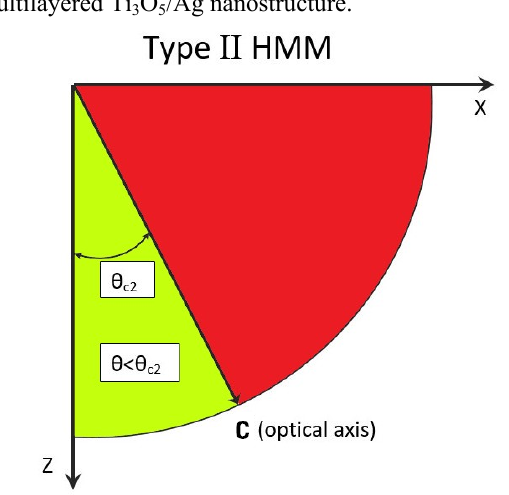
Figure 7: The spectral dependences of the angles =arcsin (Y ) 1/2 for the II type HMM on the basis of Θ 3,4 3,4 multilayered Ti O /Ag nanostructure. 3 5